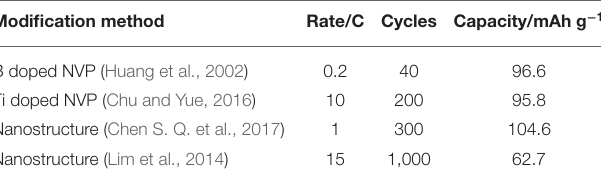
TABLE 2 | Cycle performances of NVP by various modification